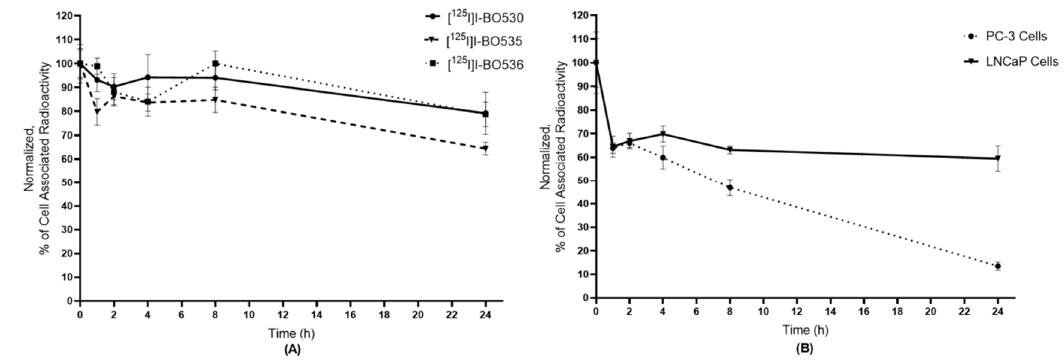
Figure 5. Cellular retention of activity (normalized to 0 h) after interrupted incubation for [ 125 I]I-BO530, [ 125 I]I-BO535, and [ 125 I]I-BO536 on PC-3pip cells ( A ), and for [ 125 I]I-BO530 on PC-3 and LNCaP ( B ) cells. Data are presented as mean value ± standard deviation.